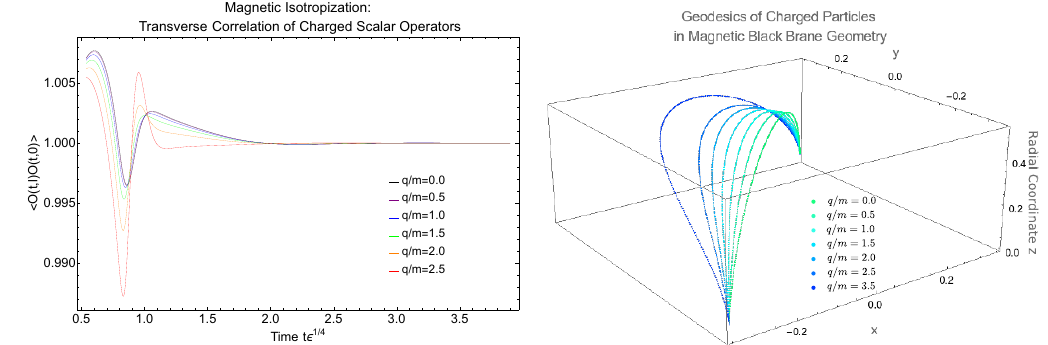
Figure 16 . Left: 2-point correlation function of a charged scalar operator in a neutral thermalizing fluid (dual to the evolution towards a magnetic black brane geometry), ρ = 0, functions above are computed for l = 0 . 7 √ 2. Right: the geodesics of a charged particle of various charge to mass ratios, q/m displayed at a boundary time of v = 2 . 71. These geodesics were used to calculate the correlation functions shown on the